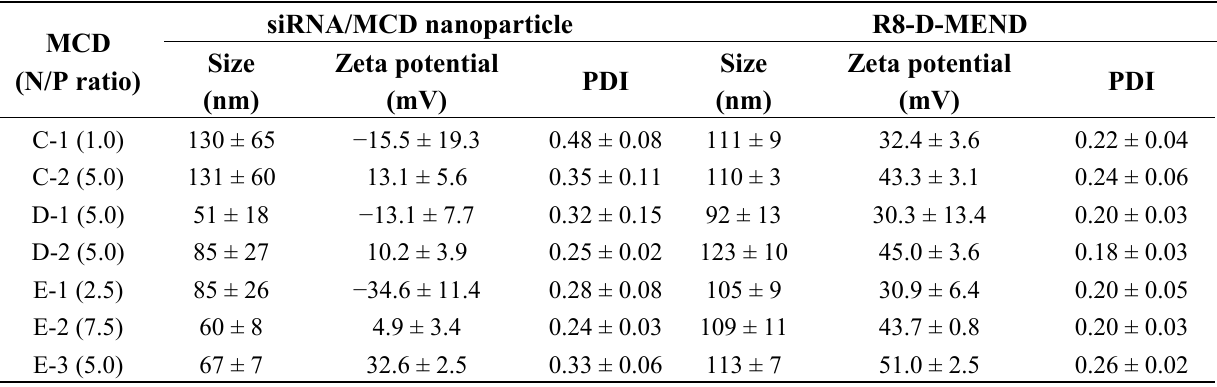
Table 2. Characteristics of nanoparticles of siRNA targeting Luciferase formed using various MCDs Data are represented by the mean ± S.D. (n =